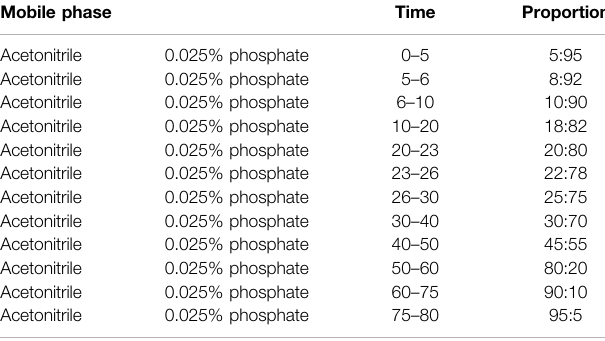
TABLE 1 | Gradient elution conditions of acetonitrile − 0.05% phosphoric acid. Mobile phase Time